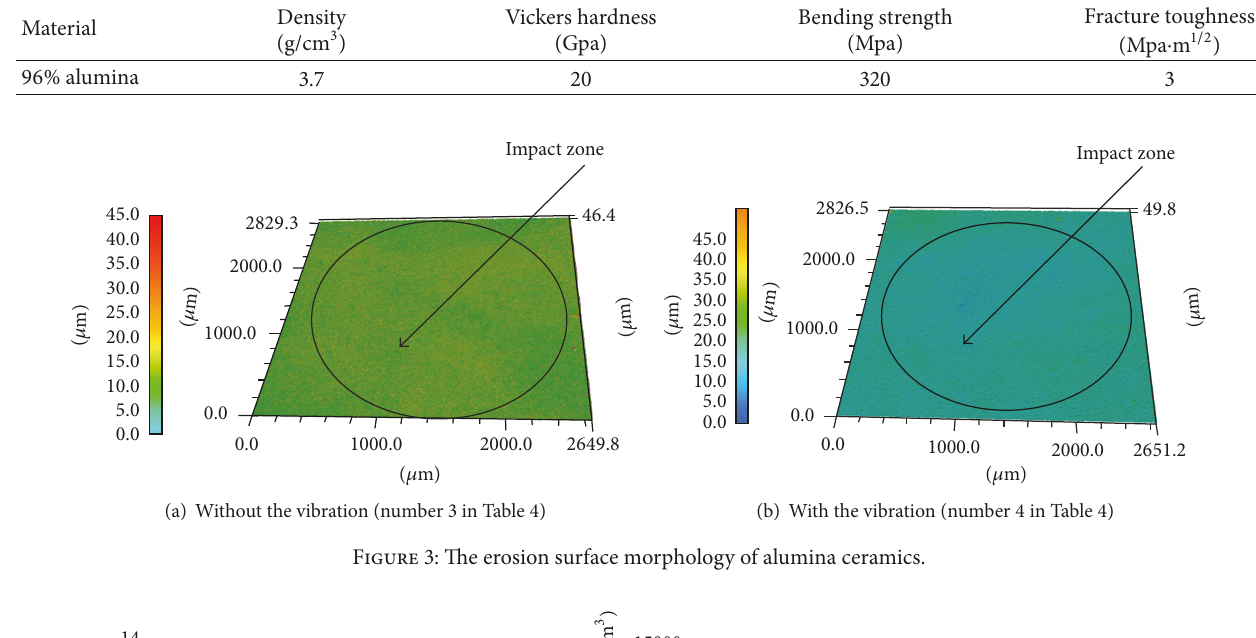
Table 1: The mechanical property of alumina ceramic [14].